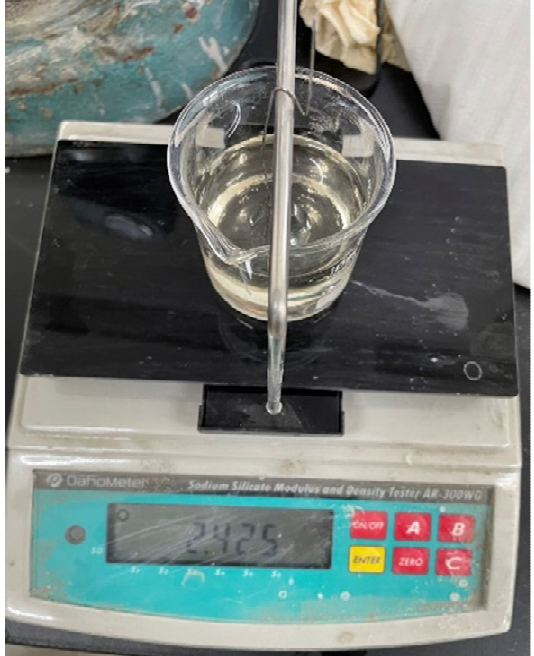
Figure 1. Test of water glass modulus.